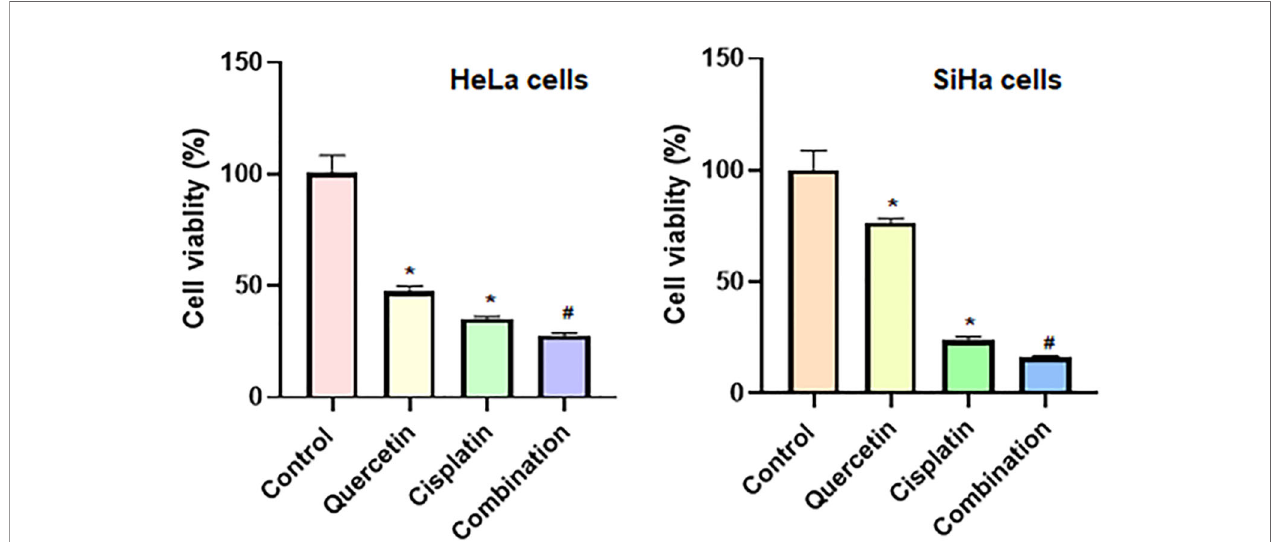
FIGURE 8 | Quercetin enhances cisplatin-induced inhibition of viability of cervical cancer cells. CCK-8 assay was utilized to measure the cell viability in HeLa and SiHa cells after treatments with quercetin or cisplatin or combination. HeLa cells were treated with 15 m M quercetin and 15 m M cisplatin for 24 h, and SiHa cells were treated with 25 m M quercetin and 15 m M cisplatin for 48 h. * P < 0.05 vs control group; # P < 0.05 vs quercetin alone or cisplatin